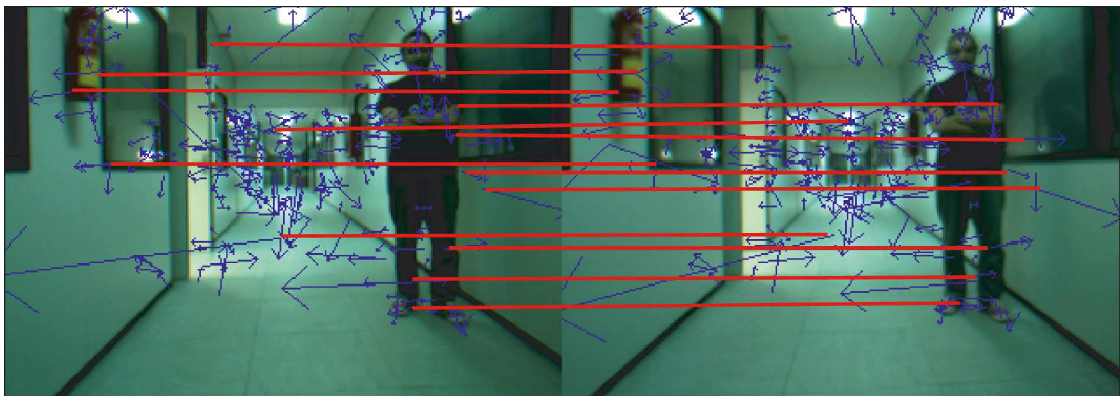
Figure 5. Matched SIFT features between left and right images from the stereo pair shown in Figure 3. Red line represents matched